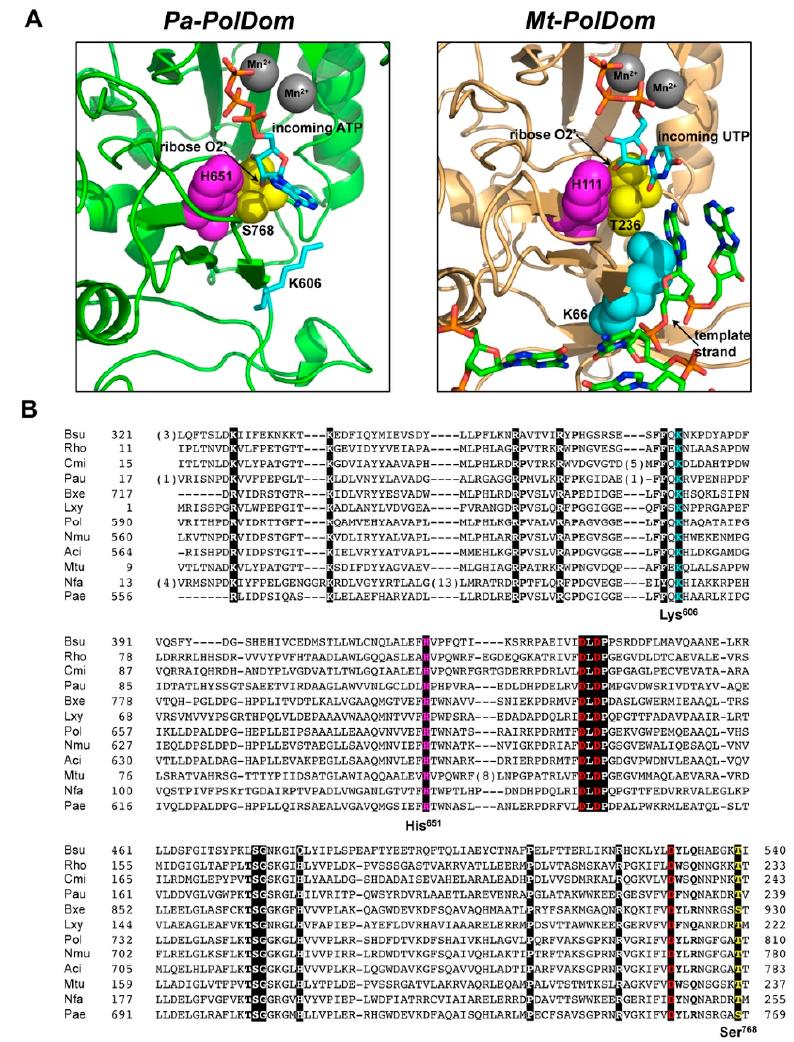
Figure 1. Catalytic active site of bacterial PolDom. ( A ) Detailed view of the incoming NTP insertion site of Pa -PolDom (PDB 2FAQ; [31]; left panel) and Mt -PolDom (PDB 3PKY; [23]; right panel). 2 ′ -OH contacting residues His651 and Ser768 ( Pa -LigD) and the homologs His111 and Thr236 ( Mt -LigD) studied here are represented as magenta and yellow spheres. Template strand interacting residue Lys66 ( Mt -LigD) and the homolog Lys606 ( Pa -LigD) is shown as blue spheres. ( B ) Multiple amino acid sequence alignment of the PolDom of bacterial LigDs. Numbers indicate the amino acid position relative to the N-terminus of each LigD. Because of the large number of sequences, only selected representatives are aligned. Name of organisms are abbreviated as follows: Bsu, Bacillus subtilis ; Rho, Rhodococcus ; Cmi, Clavibacter michiganenses ; Aau, Arthobacter aurescenses ; Bxe, Burkholderia xenovorans ; Lxy, Leifsonia xyli ; Pol, Polaromonas ; Nmu, Nitrosospira multiformis ; Aci, Acidovorax ; Pae, Pseudomonas aeruginosa ; Mtu, Mycobacterium tuberculosis ; Nfa, Nocardia farcinica . Catalytic aspartates are indicated in red letters, residues homologous to Pa -LigD His651 and Ser768 in magenta and yellow, respectively, and conserved lysine corresponding to Pa -LigD Lys606 is indicated in cyan. Other highly conserved residues are indicated with white letters over a dark background. The crystallographic structures of the PolDom of P. aeruginosa LigD ( Pa- PolDom) with a Mn 2+ - ATP bound at the active site [31], as well as of the ternary complex of Mt- PolDom with an incoming UTP forming a Watson–Crick base pair with a templating adenine base [23] showed that the ribose